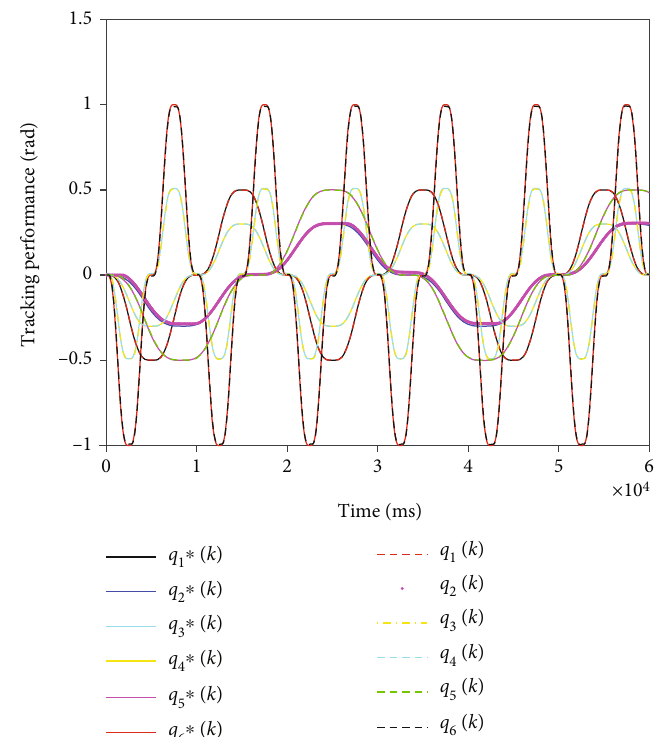
Figure 4: Tracking performance of each robotic joint controlled by PD plus.